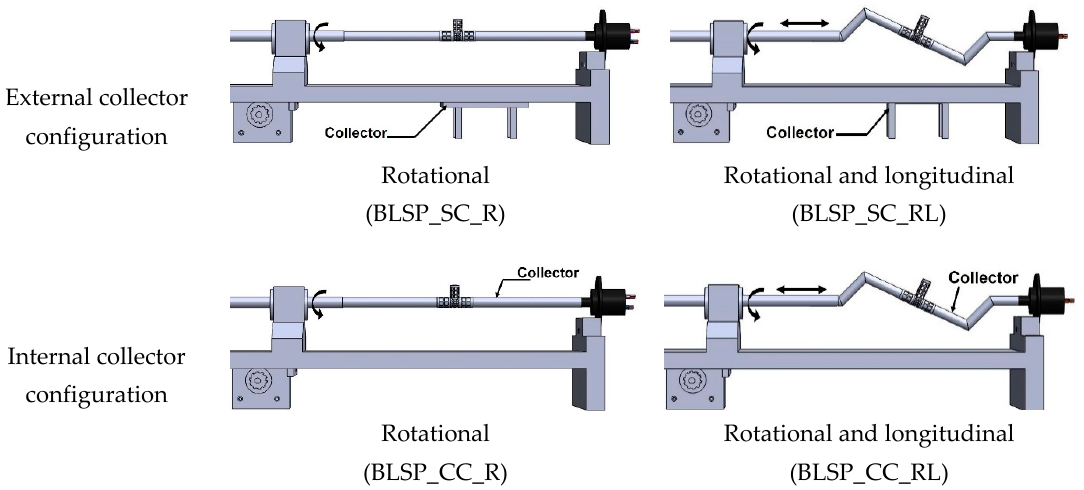
Figure 6. Schematic illustration of electrical field collector configuration and mandrel motion scheme .